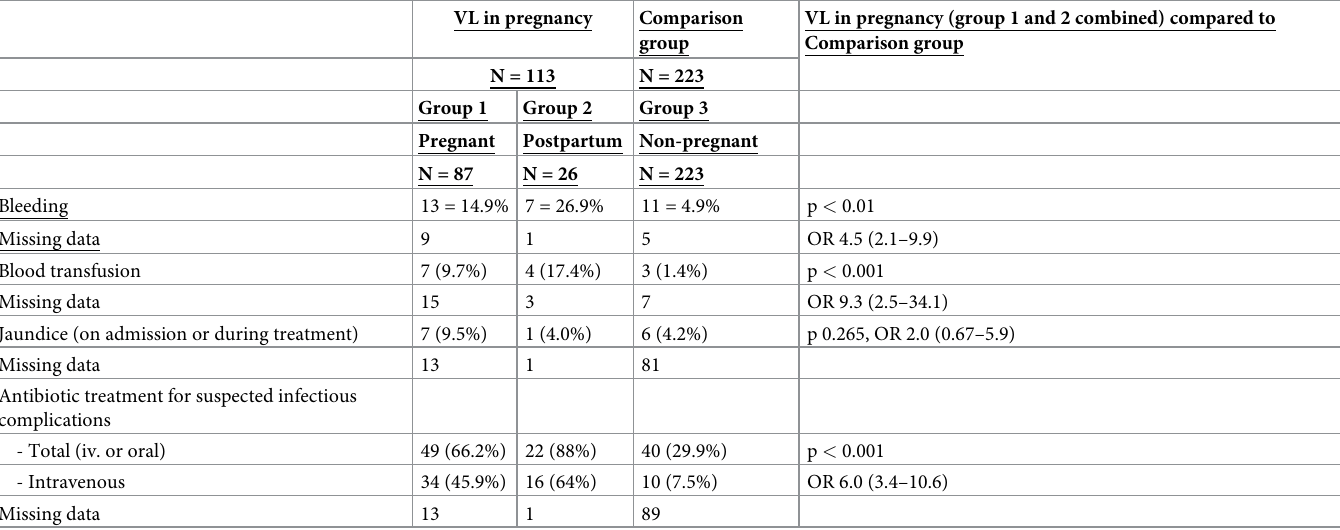
Table 2. Complications during VL